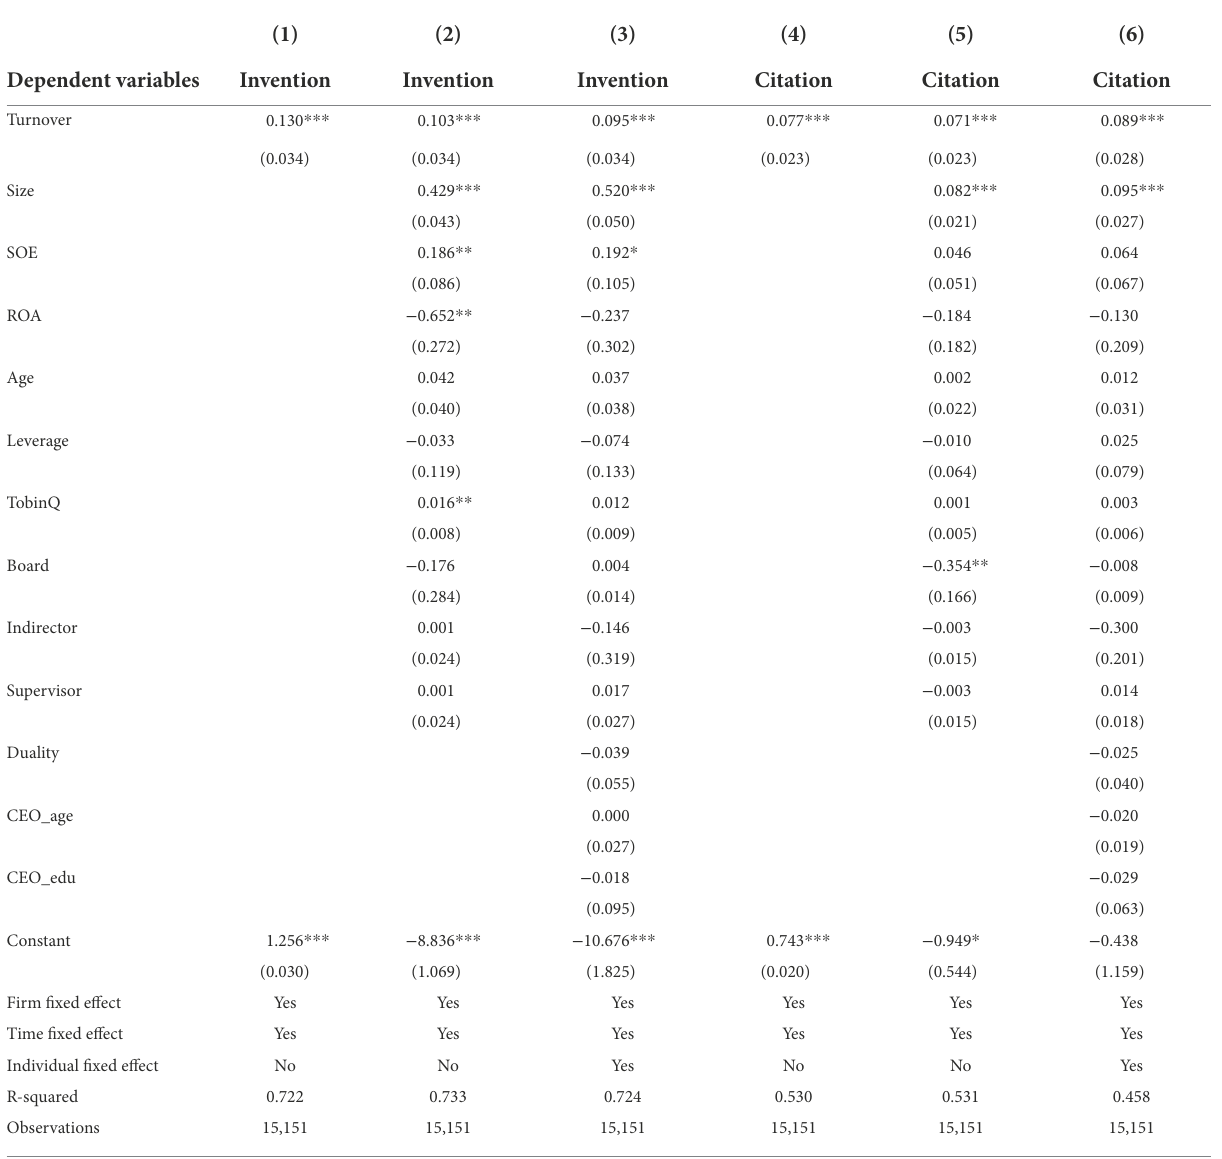
TABLE 2 Innovation quantity and innovation